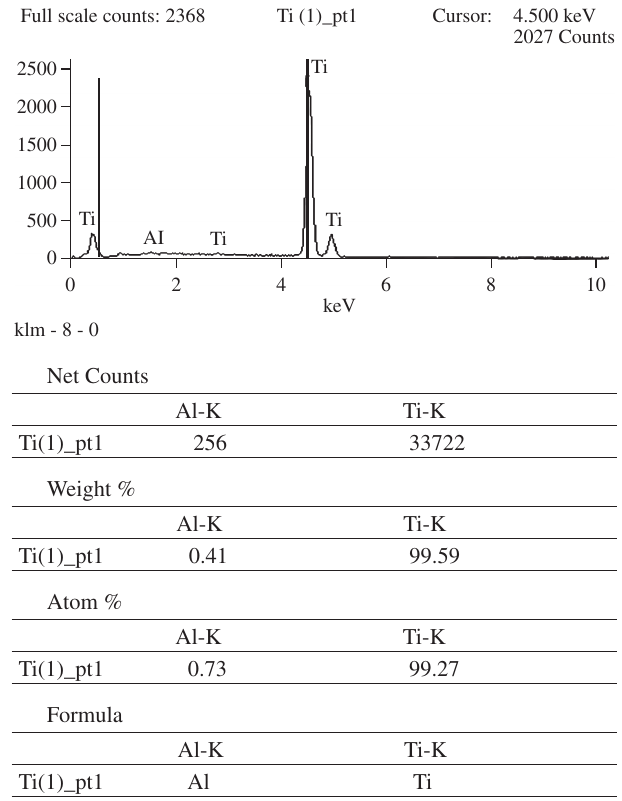
Figure 2. EDS analysis obtained for pure Ti